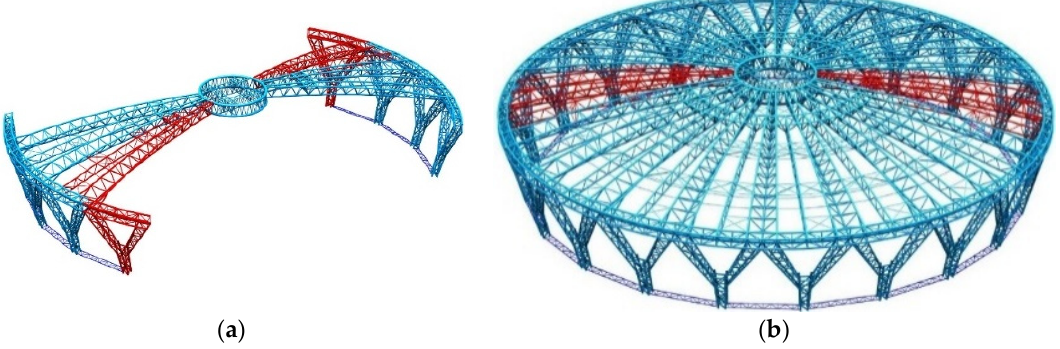
Figure 6. Schematic diagram of structural slip process. ( a ) The first slip unit, ( b ) the assembled main gymnasium.